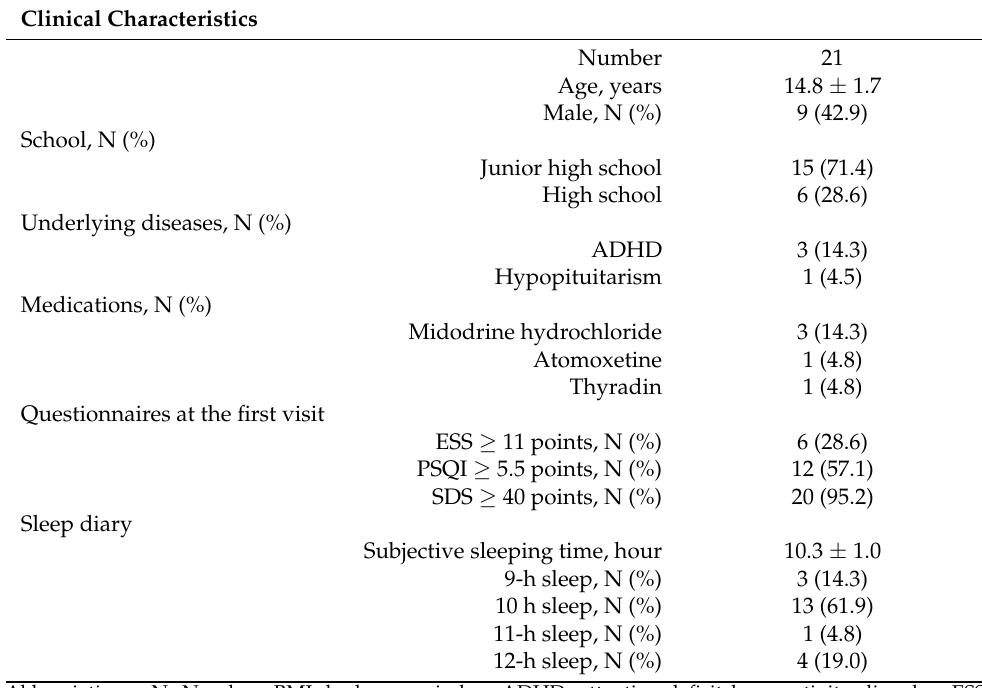
Table 1. Clinical characteristics before the combination